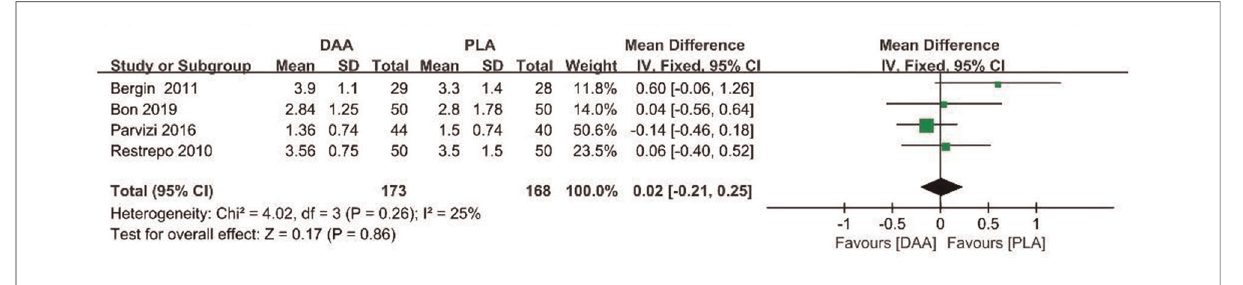
FIGURE 7 Hospitalization time outcome forest plot analyses.